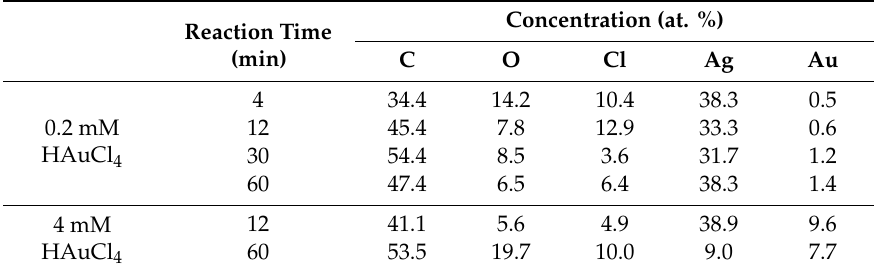
Table 2. XPS-derived surface concentrations for a series of silver films after different exposure to HAuCl 4 solutions.